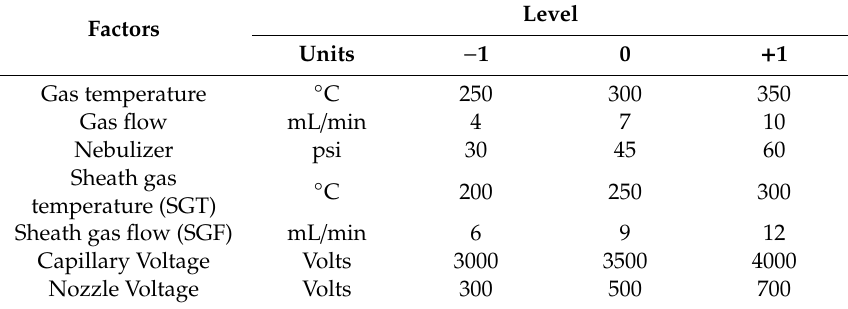
Table 5. Conditions and factors for the